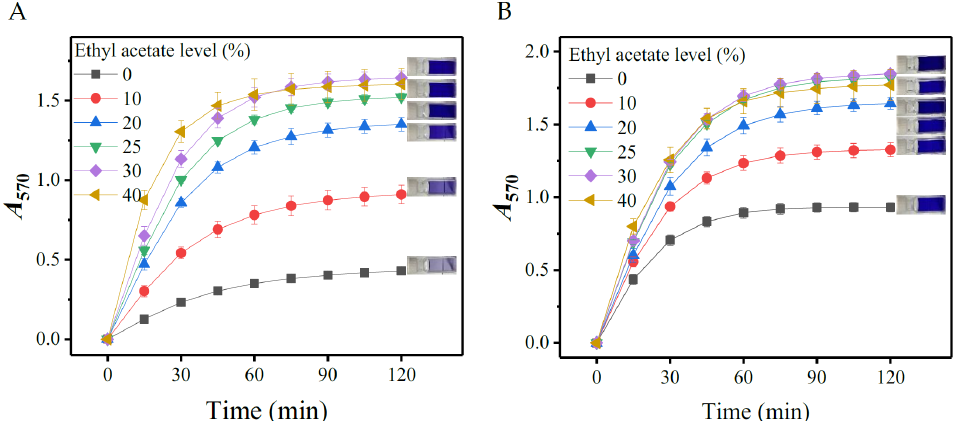
Figure 2. Effects of ethyl acetate level on color yield of gamma-aminobutyric acid ( A ) and L-glutamic acid ( B ). The chromogenic reactions were performed in SINICSs (containing 40% ethanol) supple- mented with various levels of ethyl acetate. The rightmost part of each diagram shows the reacted mixtures containing different levels (from top to bottom: 40, 30, 25, 20, 10, and 0%) of ethyl acetate. SINICS: sensitivity intensified ninhydrin-based chromogenic system; and A 570 : absorbance at 570 nm.